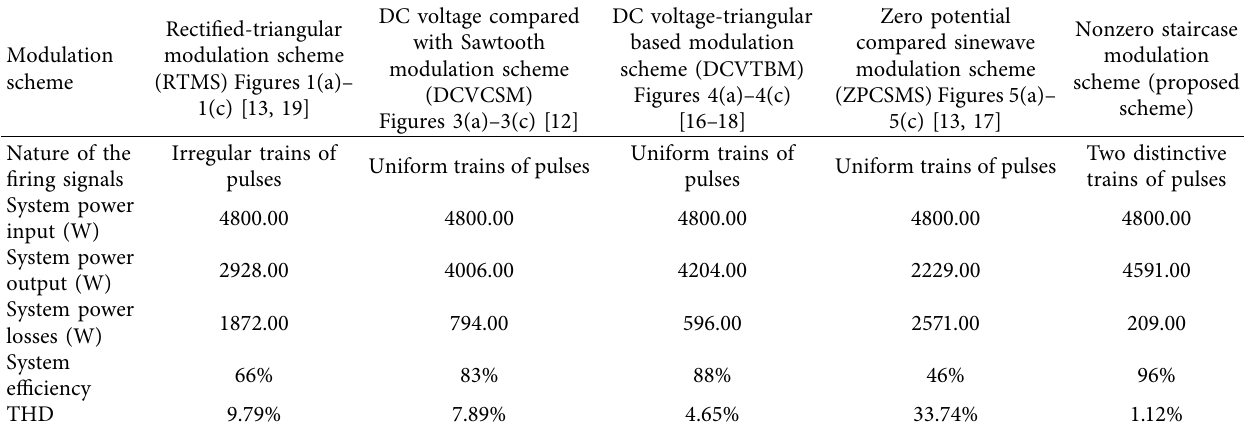
Table 6: Comparative analysis of different modulation